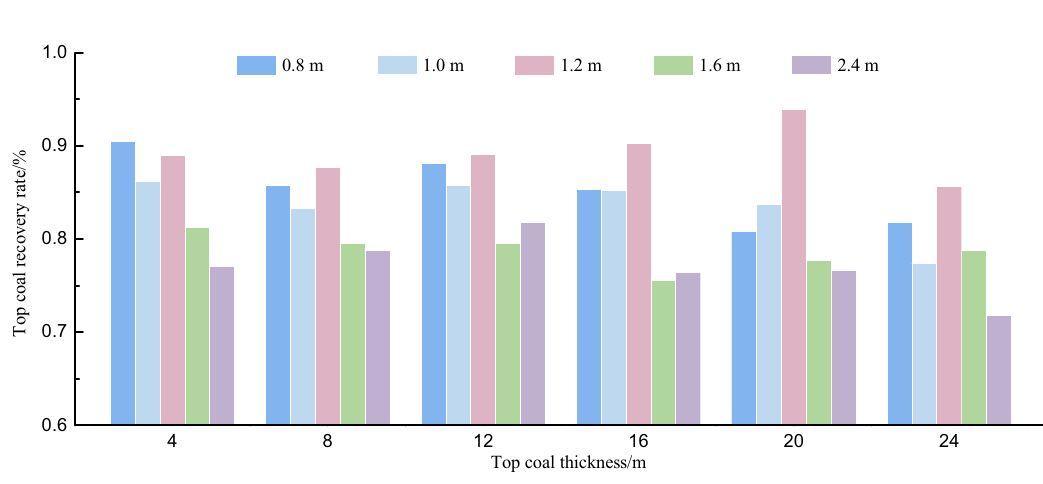
Figure 13. Statistic of top coal recovery rate under different coal-drawing interval and top coal that the smaller the TCCI and the thickness of the top coal, the smaller the difference in the amount of top coal recovered in each caving window, and the larger the TCCI and the top coal thickness is, the greater the difference in the caving amount in each caving window is. (4) Under different top coal thickness conditions, when the thickness of the top coal is 4.0 m and the TCCI is 0.8 m, the top coal recovery is the highest; when the coal seam thickness is greater than 4.0 m and the TCCI is 1.2 m, the top coal recovery is the highest. (5) With the continuous development of mechanized equipment in working face, especially the support capac- ity of hydraulic support, the width of scraper conveyor and the mining height of LTCC working face increase, the top coal caving ratio may break through the limit of 1:3, and the optimization of top coal caving interval will more consider the cooperation with mechanical equipment.